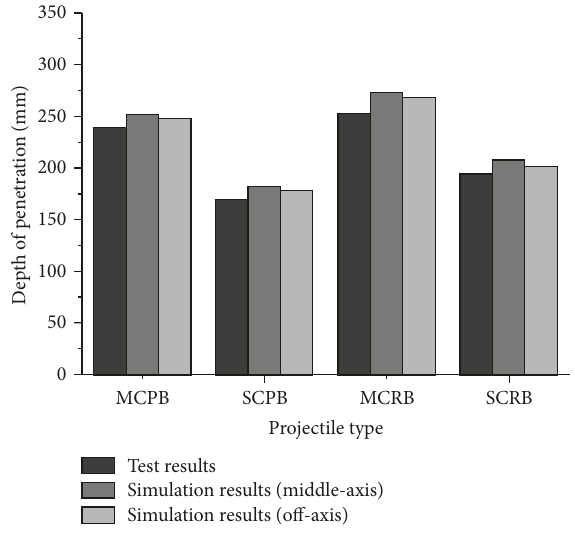
Figure 7: The contrast of DOP